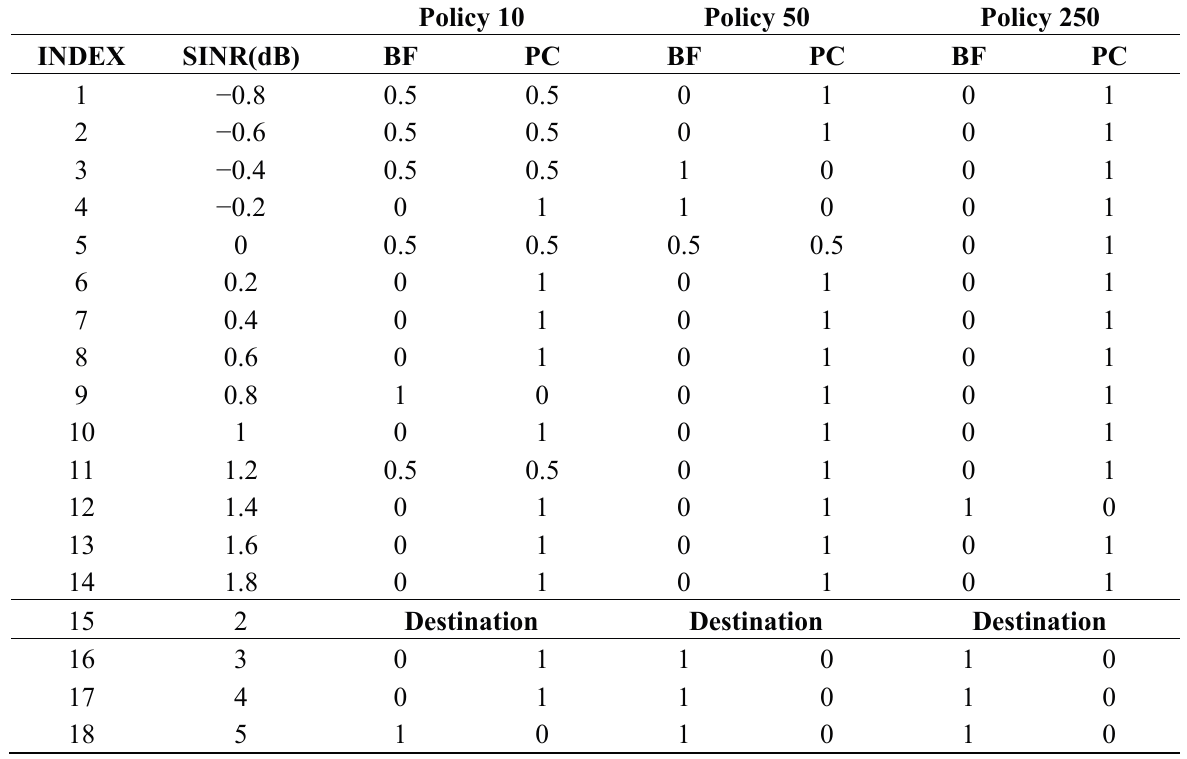
Table 3. Policy Improvement of the